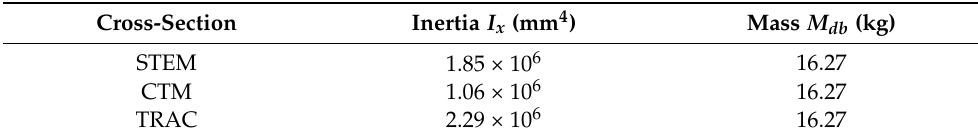
Table 1. Calculation results of three